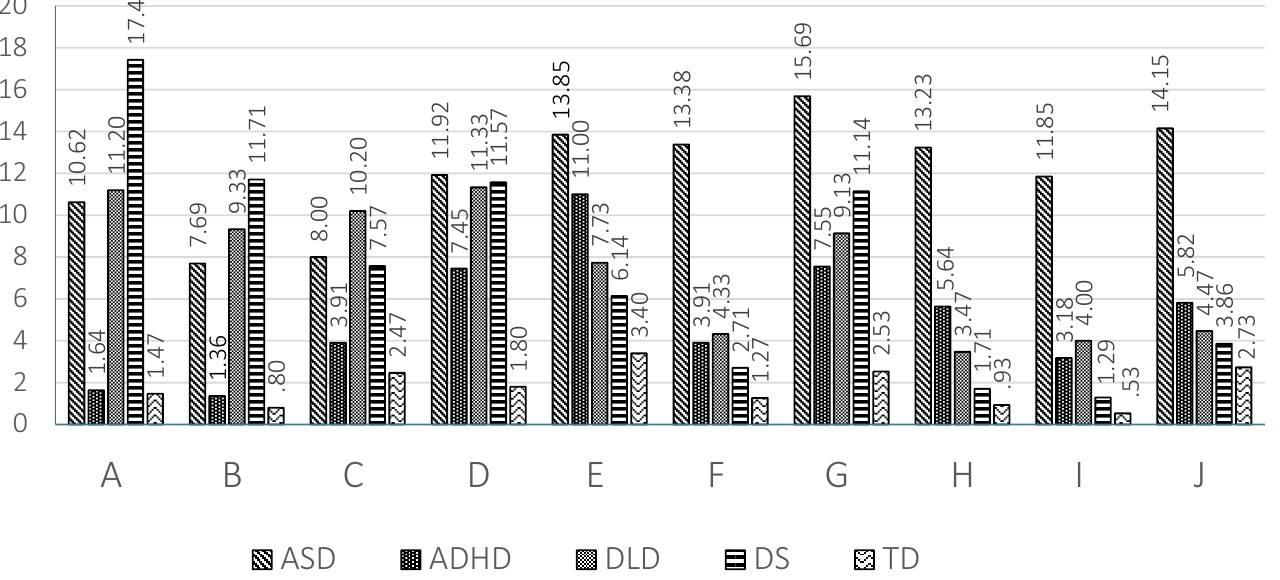
Figure 1. Means obtained by the 5 groups at preschool age in the 10 scales of the Galician CCC-2.